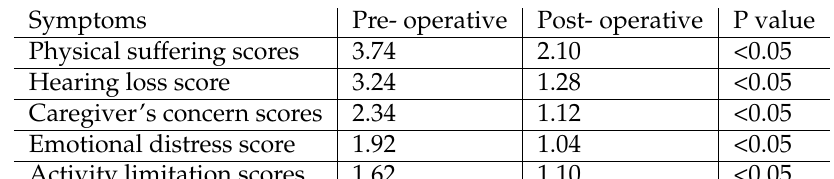
Table 3. Comparison of scores calculated on visual analogue scale